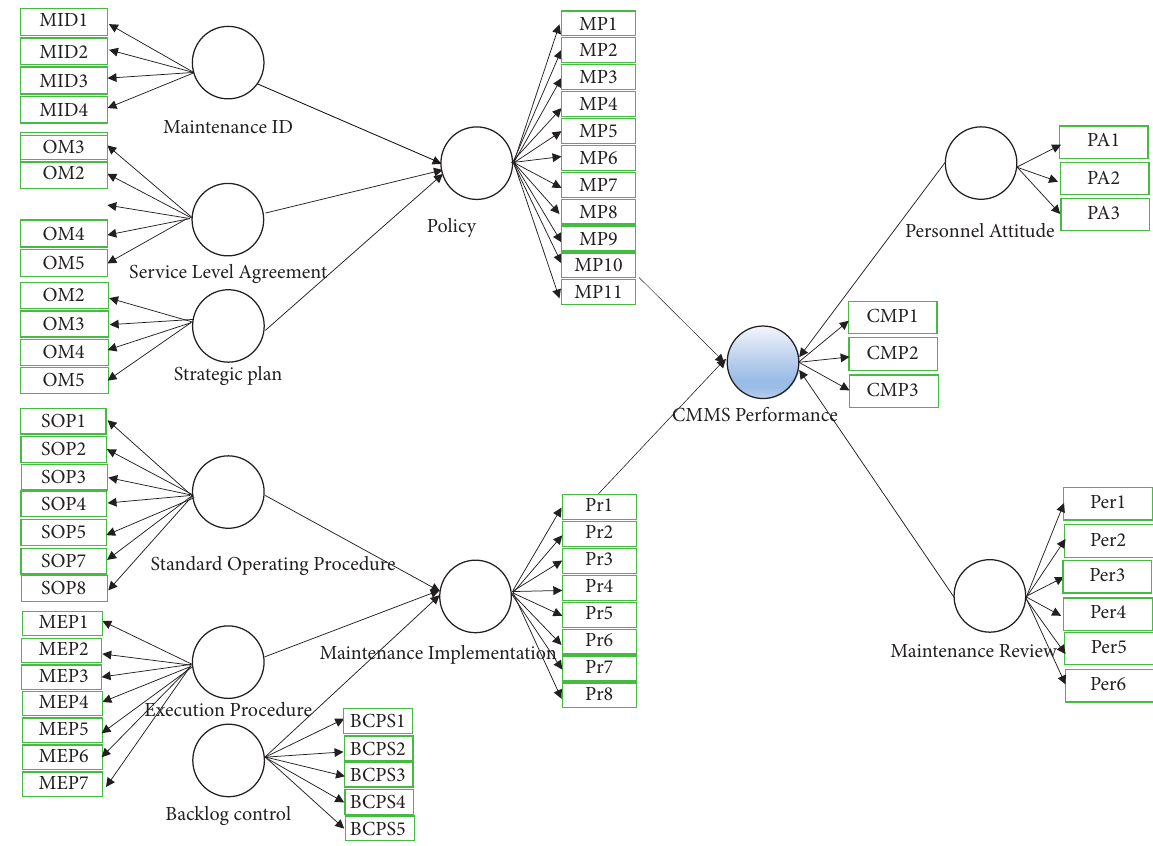
Figure 2: Hypothetical